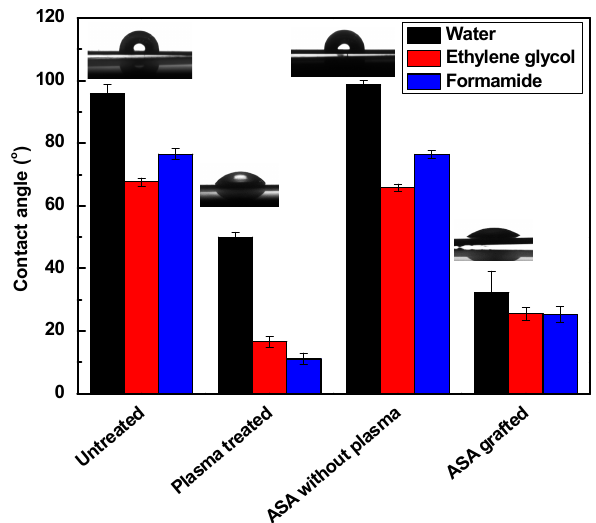
Figure 3. The contact angles of testing liquids on LDPE samples.